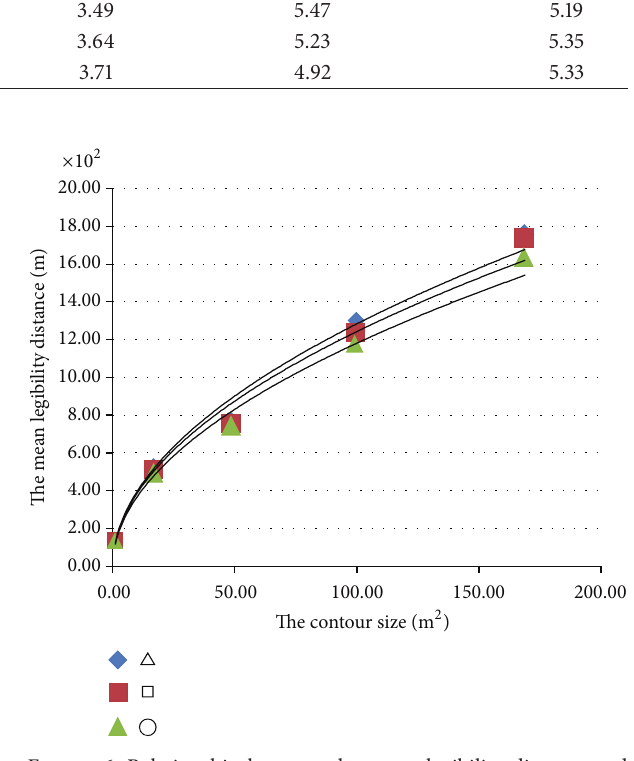
Figure 6: Relationship between the mean legibility distance and the contour size under 100km/h, where the relationship between the mean legibility distance and the contour size under 100km/h was for triangle: 𝑦 = 122.5𝑥 0.51 and 𝑅 2 = 0.902 , for rectangle: 𝑦 = 120.2𝑥 0.507 and 𝑅 2 = 0.903 , and for round: 𝑦 = 114.2𝑥 0.507 and 𝑅 2 = 0.904